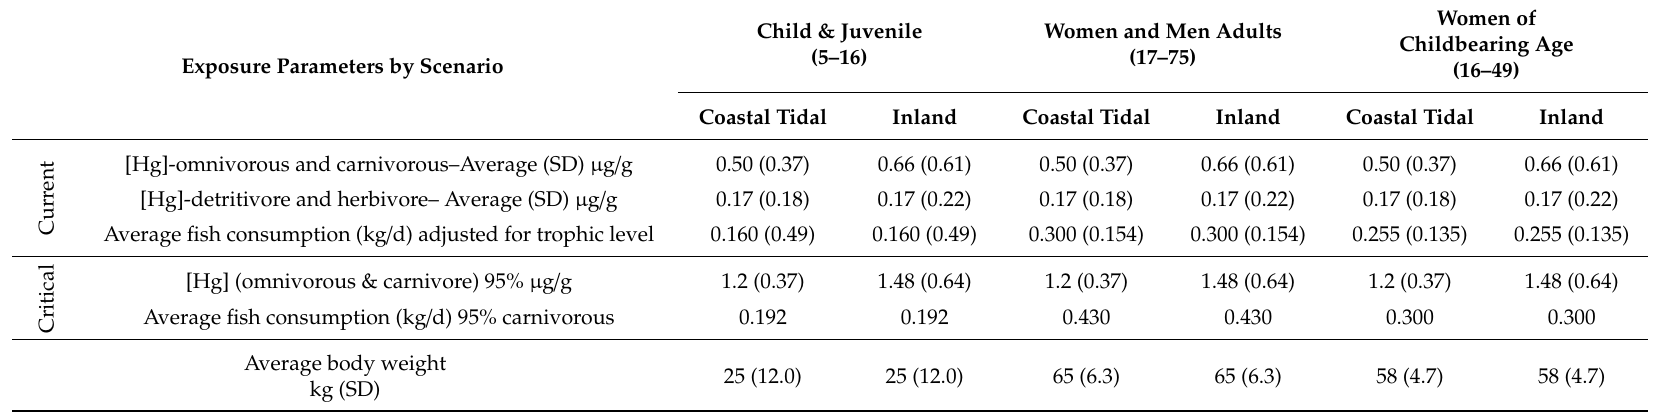
Table 3. Exposure parameters used for the health risk assessment of residents in areas influenced by coastal tides (sites 1, 2, and 3) and inland zones (sites 4 and